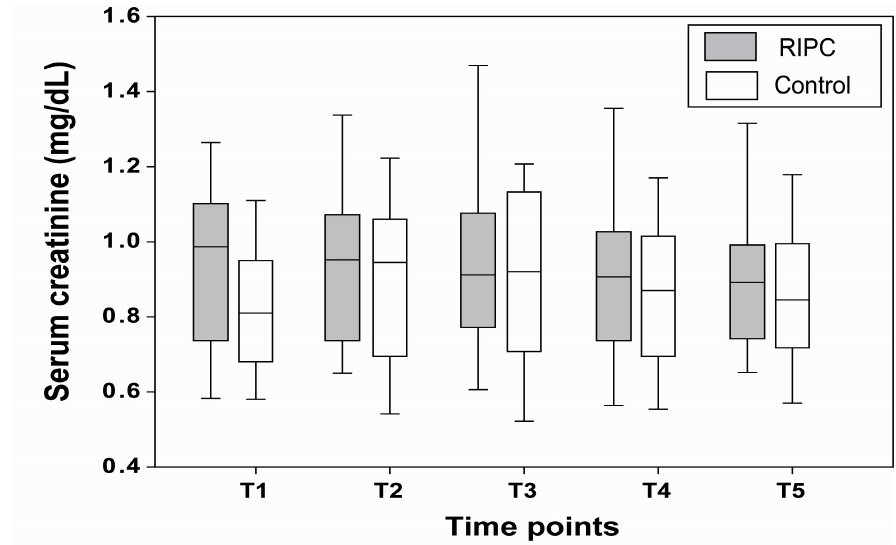
Figure 2. Comparison of time-dependent changes in the serum creatinine between the RIPC and control groups. Time points were defined as preoperative (T1), at post-anesthesia care unit (T2), postoperative day 1 (T3), postoperative day 3 (T4), and two weeks after surgery (T5).